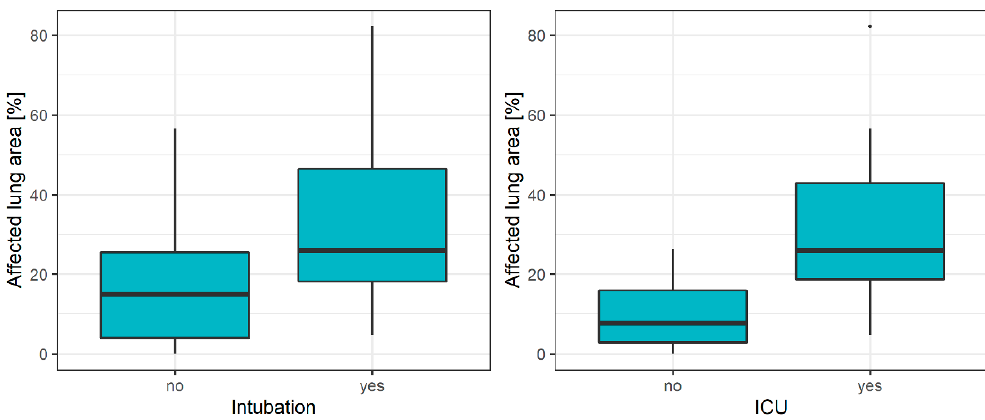
Figure 2. Boxplots of the extent of affected lung area on initial CT in relation to the two clinical endpoints—need of ICU treatment and intubation. Median lung involvement in initial CT scans is more severe in ICU (left) patients compared to patients in conventional wards. The same tendency can be seen for intubated patients (right).